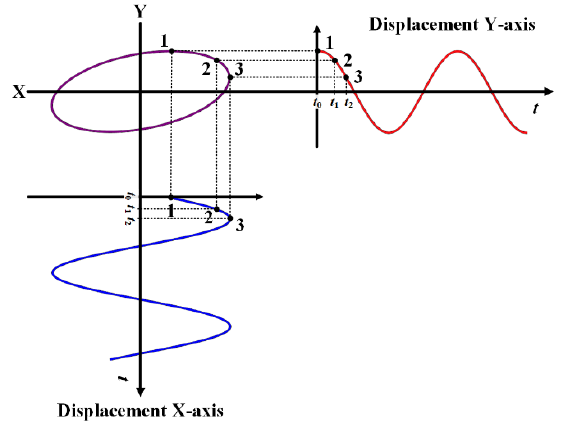
Figure 4. Orbit construction.